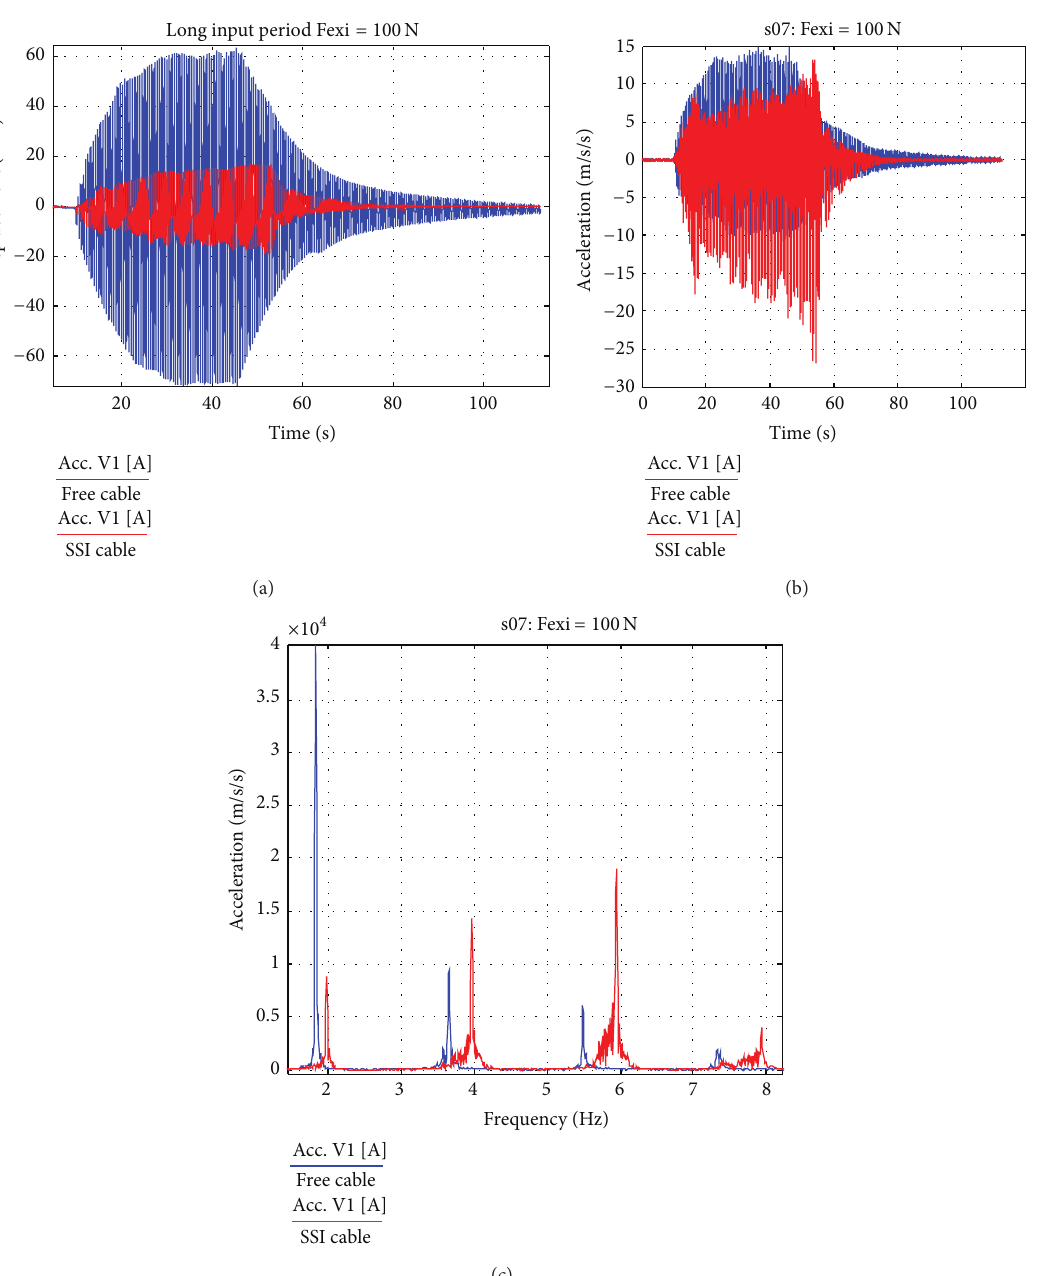
Figure 9: Displacement (a), acceleration (b), and acceleration spectrum (c) for the free and SSI cable no. 1 ( 𝐹 = 100 N on 1st mode).